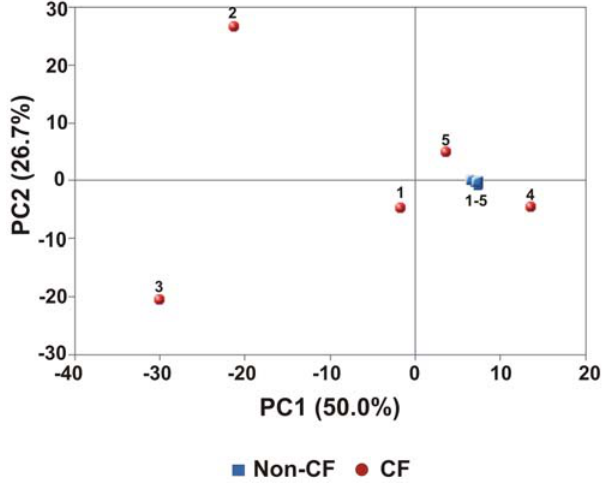
Figure 5. Principal components analysis based on best tBLASTx hits to 3074 eukaryotic viruses. Non-CF viromes are shown in blue and CF viromes are shown in red.